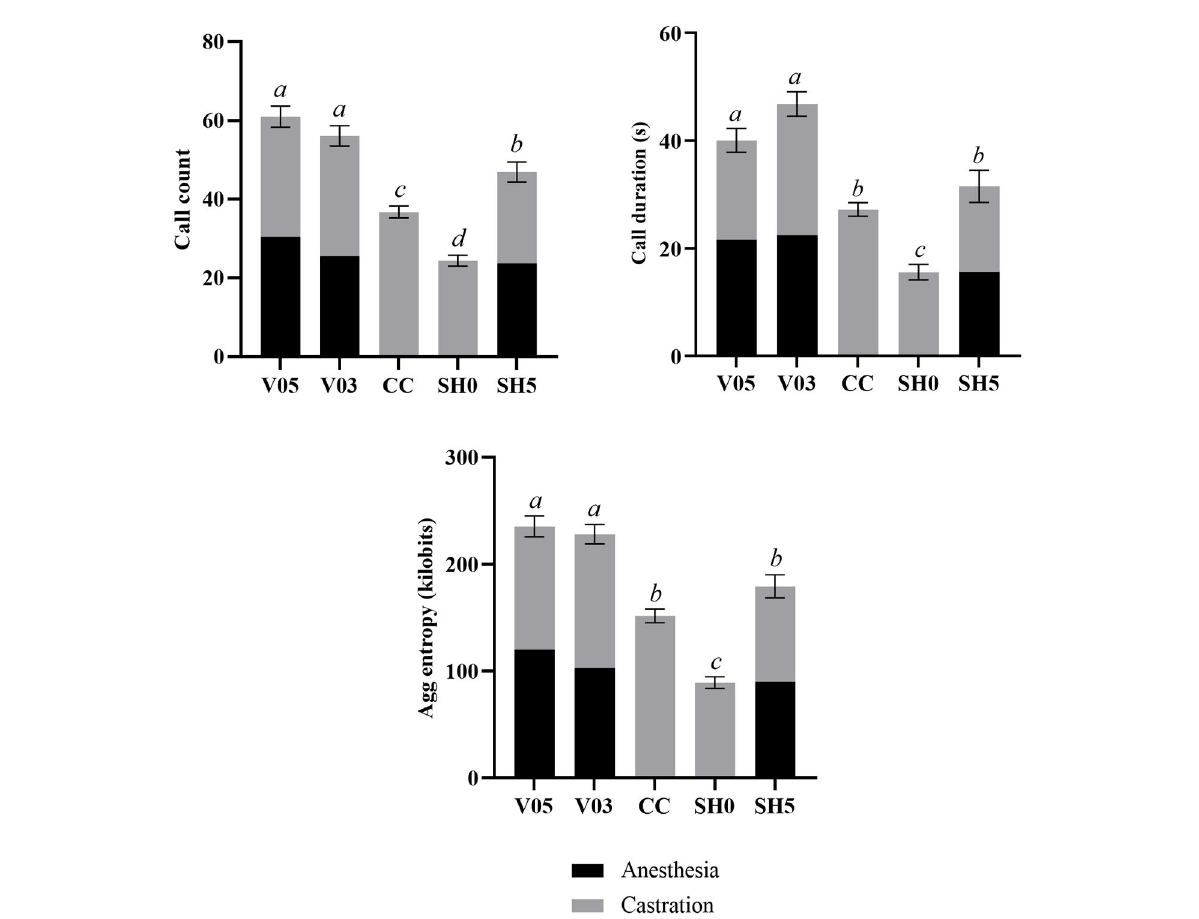
FIGURE1 Combined call count, call duration and aggregated entropy parameters recorded during injection of local anesthetic and castration. Different letters indicate significant differences between treatments, P adj ≤ 0.05; Error bars indicate standard errors of the cumulative averages. V05, intra-testicular injection of 0.5mL of anesthetic per testis ( n = 41); V03, intra-testicular injection of 0.3mL of anesthetic per testis ( n = 42); CC (control-castrated), castration without anesthesia ( n = 43); SH0, sham handling with one stay in the bench ( n = 42); SH5, sham handling with two stays in the bench ( n =